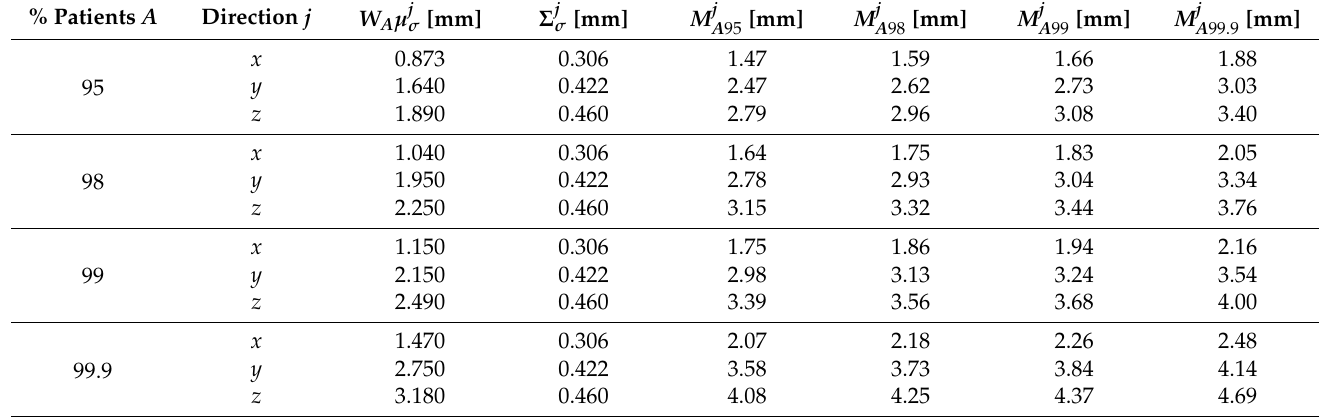
Table 5. Safety margins using the time length intervals I = 150 s.